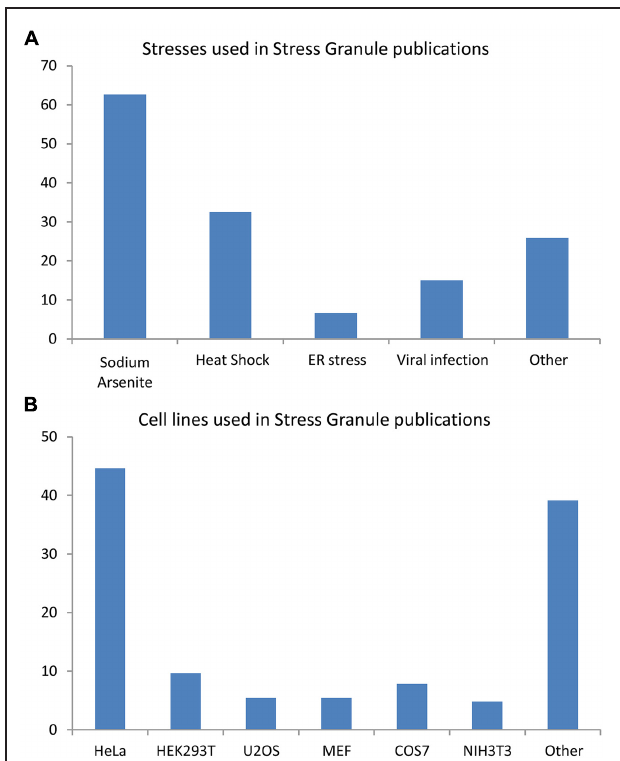
FIGURE 1 | Cell lines and stress inducing agents used in stress granule studies. Analysis of 154 articles published between 1999 and 2014. Some publications used many cells type and/or many stresses. (A) Stresses involved in stress granule (SG) studies. (B) Cell lines used in SG